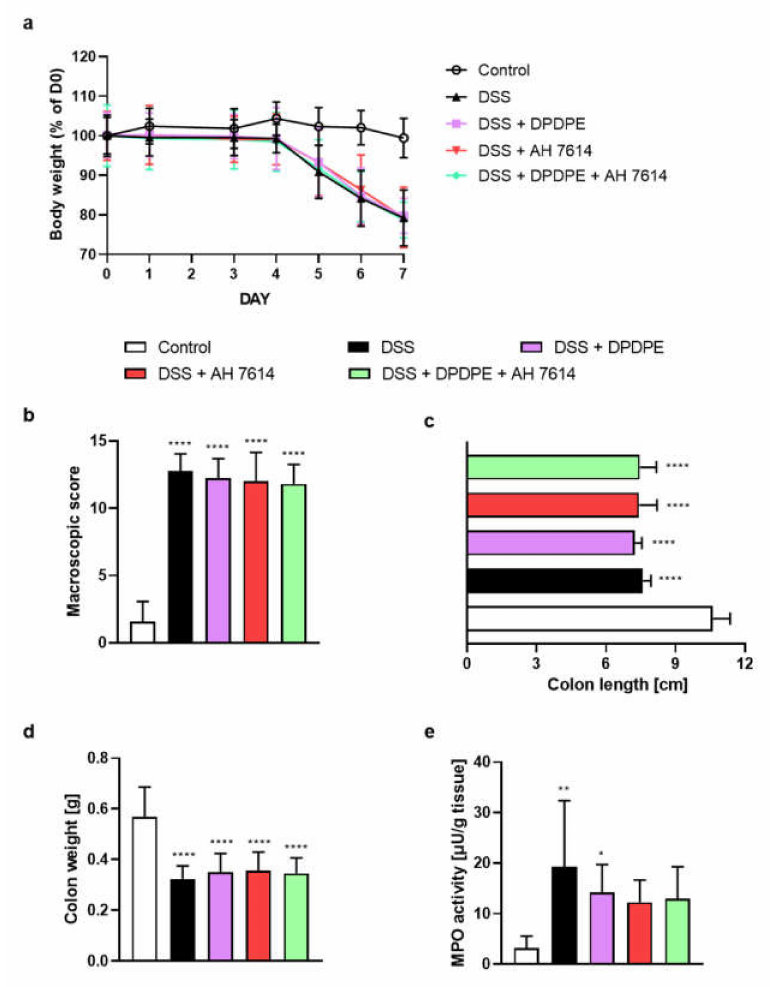
Figure 3. The i.p. administration of DOR agonist DPDPE (0.3 mg/kg BW) and FFAR4 antagonist AH 7614 (1 mg/kg BW) from day 3 to day 6, both twice daily did not alleviate symptoms of DSS-induced colitis in mice. Figure shows data for the body weight loss ( a ), macroscopic score ( b ), colon length ( c ), colon weight ( d ) and MPO activity ( e ). * p < 0.05, ** p < 0.01 and **** p < 0.0001, as compared